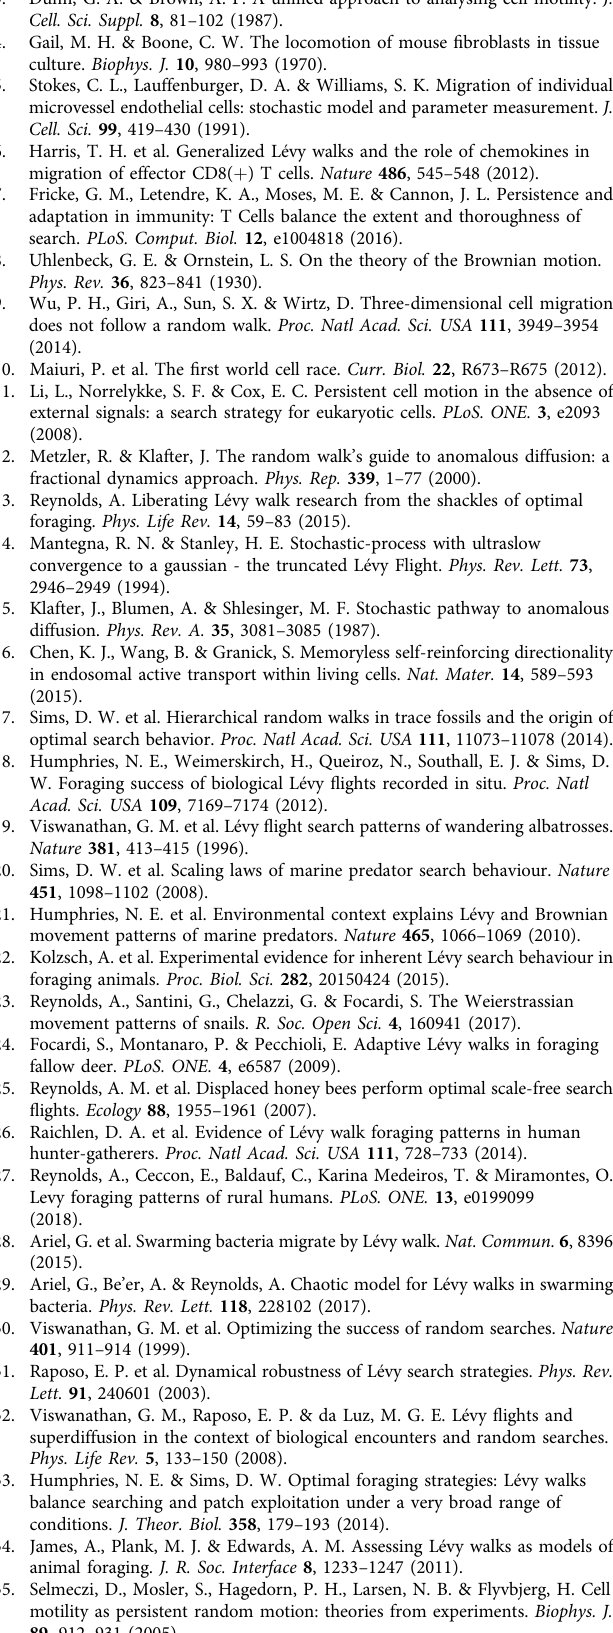
Table 1. Power law and exponential distribution parameters were estimated using analytical expression for maximum likelihood estimator, as discussed elsewhere 56,57 . Parameters for truncated power law, log-normal, and stretched exponential distributions were found using numerical maximum likelihood esti- mation and veri fi ed by visual inspection of likelihood maps. The appearance of largely negative μ values in case of log-normal model is demonstrated in Supple- mentary Figure 6. Effectively, the log-normal curve is being stretched to better fi t power law-like distribution of the data, suggesting that log-normal is not the optimal model for the data. When using only positive μ , the resulting log-normal likelihood and, therefore, wAIC are worse. The resulting parameters are shown in the Supplementary Table 2. Parameter a is a lower cutoff parameter, the choice of which is described below, and b is an upper cutoff parameter used in truncated power law estimation, and corresponds to the maximal point in each dataset. Lower cutoff estimation: To estimate the choice of the lower cutoff parameter a , we used a technique based on reweighted Kolmogorov – Smirnov (rKS) statistic, described in detail in ref. 56 . In brief, the rKS is calculated for all a values taken from the set of unique values of persistence times in each dataset. Then, a is chosen where rKS is minimal and the number of remaining data points after thresholding by a is not less than 50% of the original dataset. In cases of truncated and regular power law, exponent values in Table 1 are shown for lower cutoffs